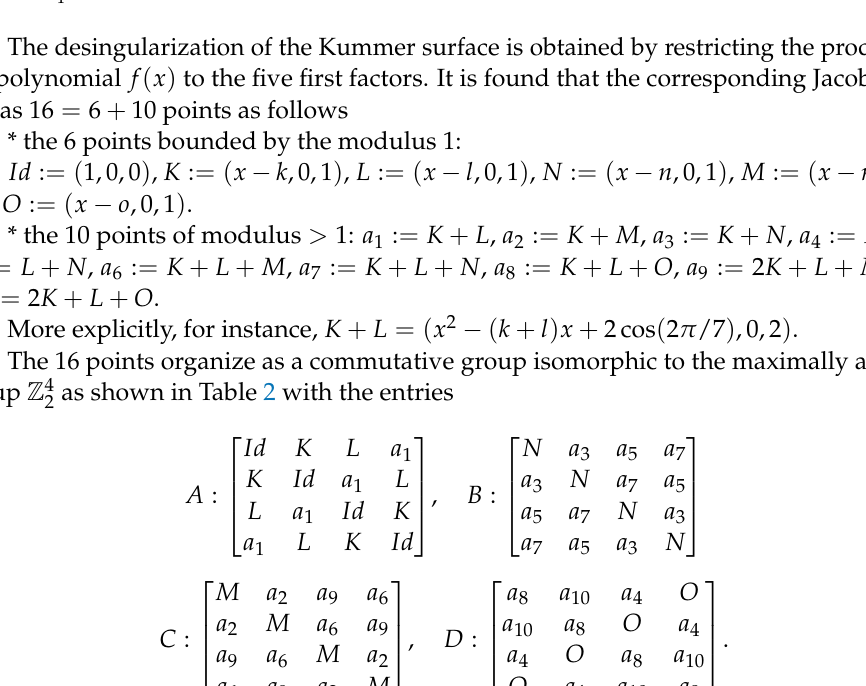
Figure 2. ( a ) A standard plot of the Kummer surface in its 3-dimensional projection, ( b ) a section at constant x 4 of the Kummer surface defined in Section